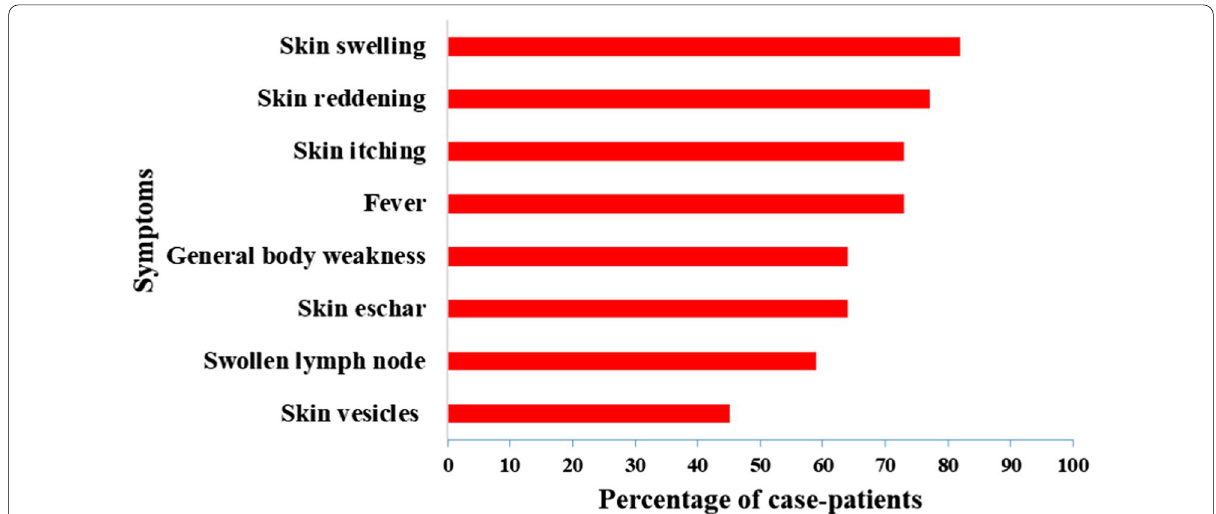
Fig. 2 Symptoms presented by 22 case‑patients during the anthrax outbreak in Kiruhura District, May